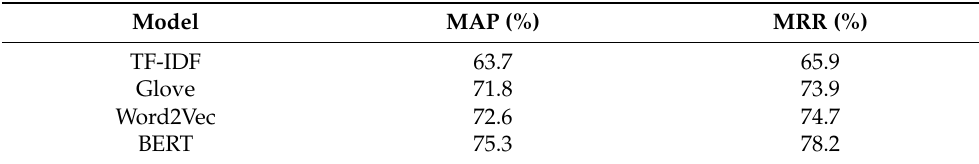
Table 2. Model matching effect under different embedding